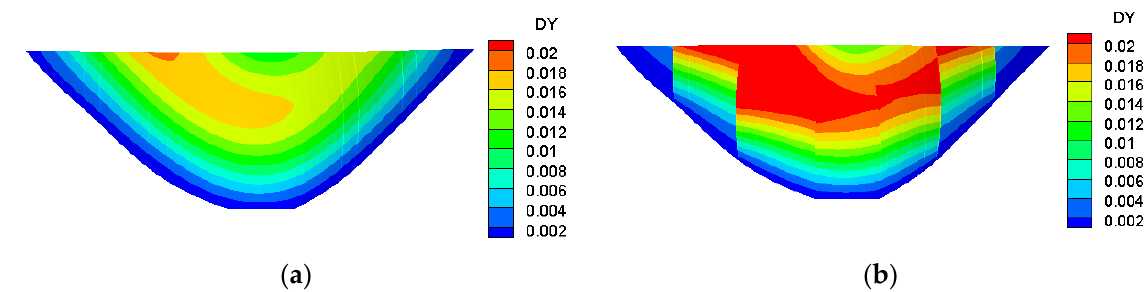
Figure 16. The distribution of along-river displacement on the arch-dam upstream surface of different transverse joint models. ( a ) M1. ( b ) M2.